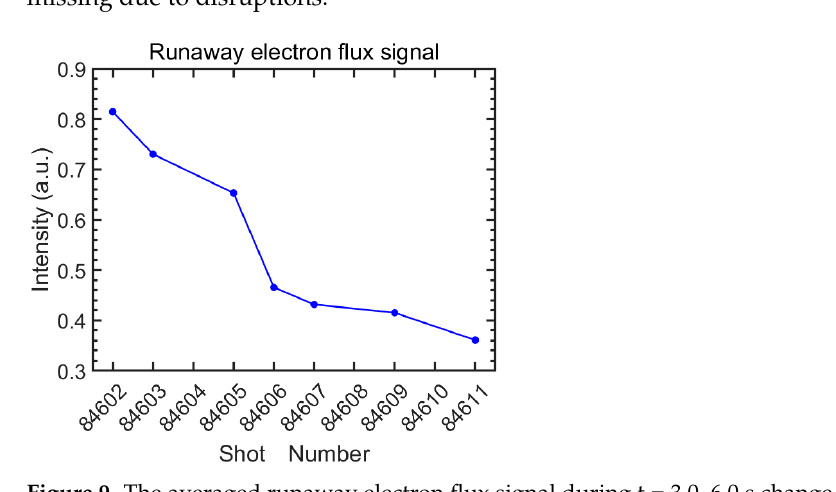
Figure 8. Time evolution of runaway electron flux signal in two discharges before (#84602, blue line) and after (#84611, red line) lithium granule injection.